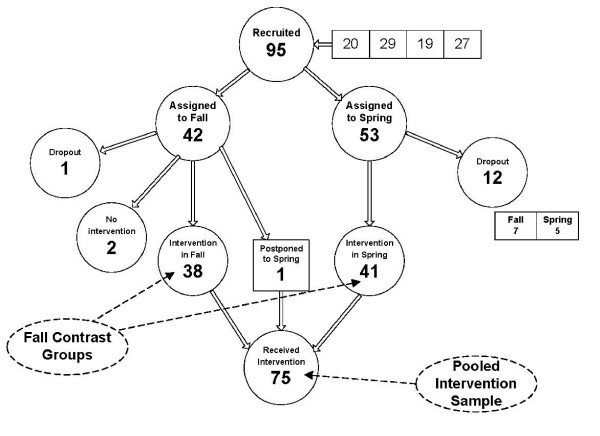
Participant Flow